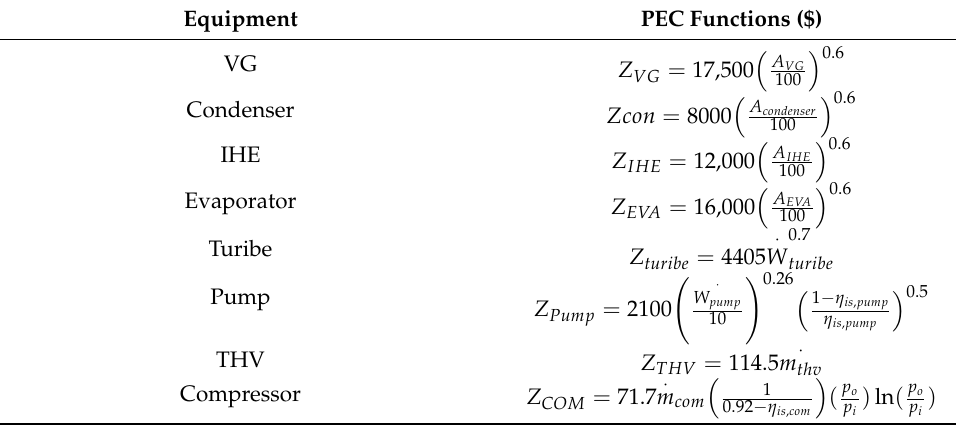
Table 1. The investment cost equation of equipment. Equipment PEC Functions